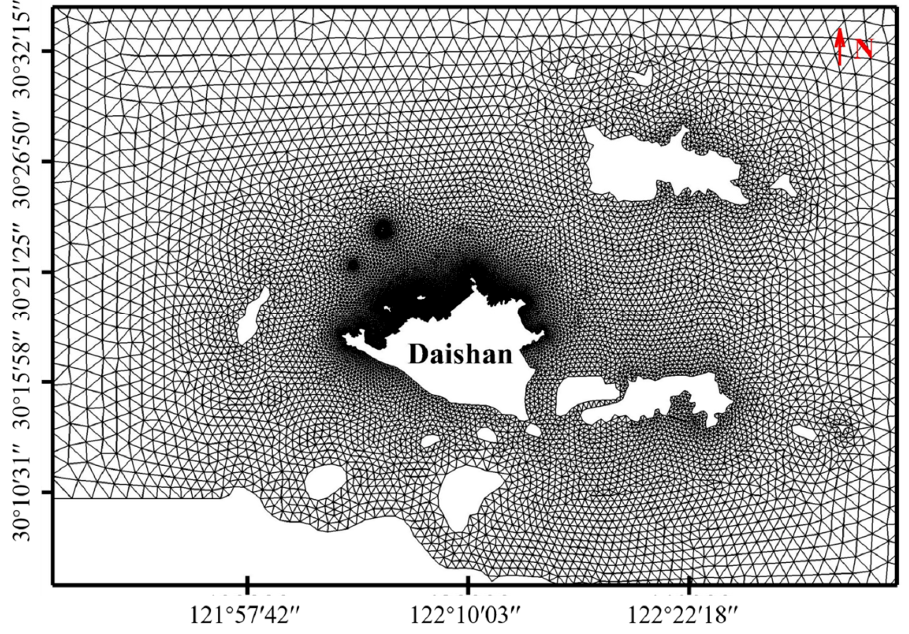
Figure 12. A mesh map of the small model area.